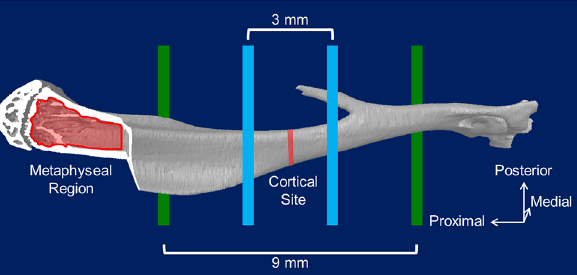
Fig 3. Location of mechanical tests and micro-computed tomography ( μ CT) regions of interest. The diaphysis of each bone was loaded using 4-point bending with the medial surface in tension. The bottom support points (green) were located 9mm apart and the top loading points (blue) were located 3mm apart. The metaphyseal region used for trabecular analyses began just distal to the growth plate in the proximal metaphysis and extended distally by 12% of the overall bone length. The cortical standard site was located 45% the total bone length from the proximal growth plate. Strain gauges used for calibration were in the region spanning the cortical standard site on the anteromedial